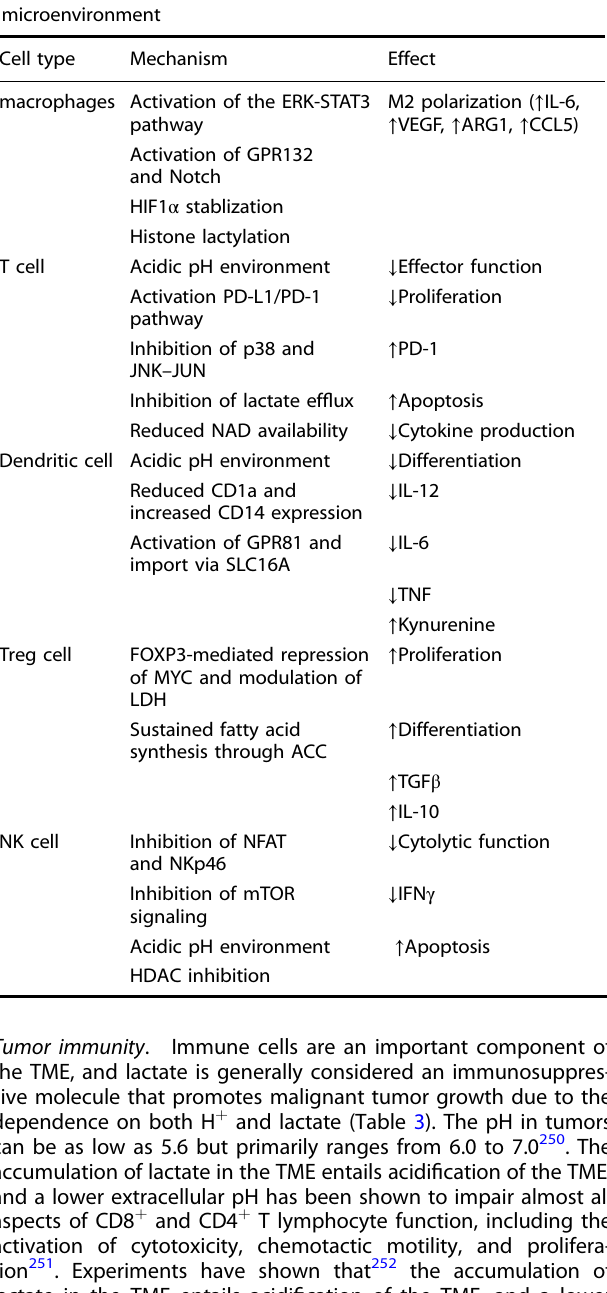
Table 3. Effects of lactate on immune cells in